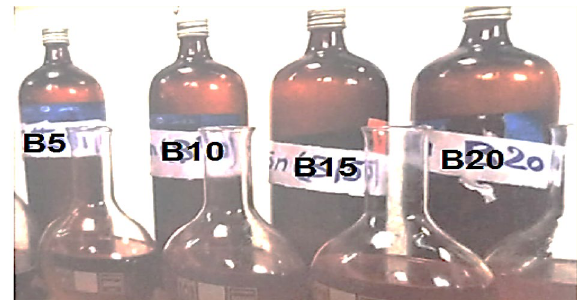
Figure 1. Photos of biodiesel blends samples.